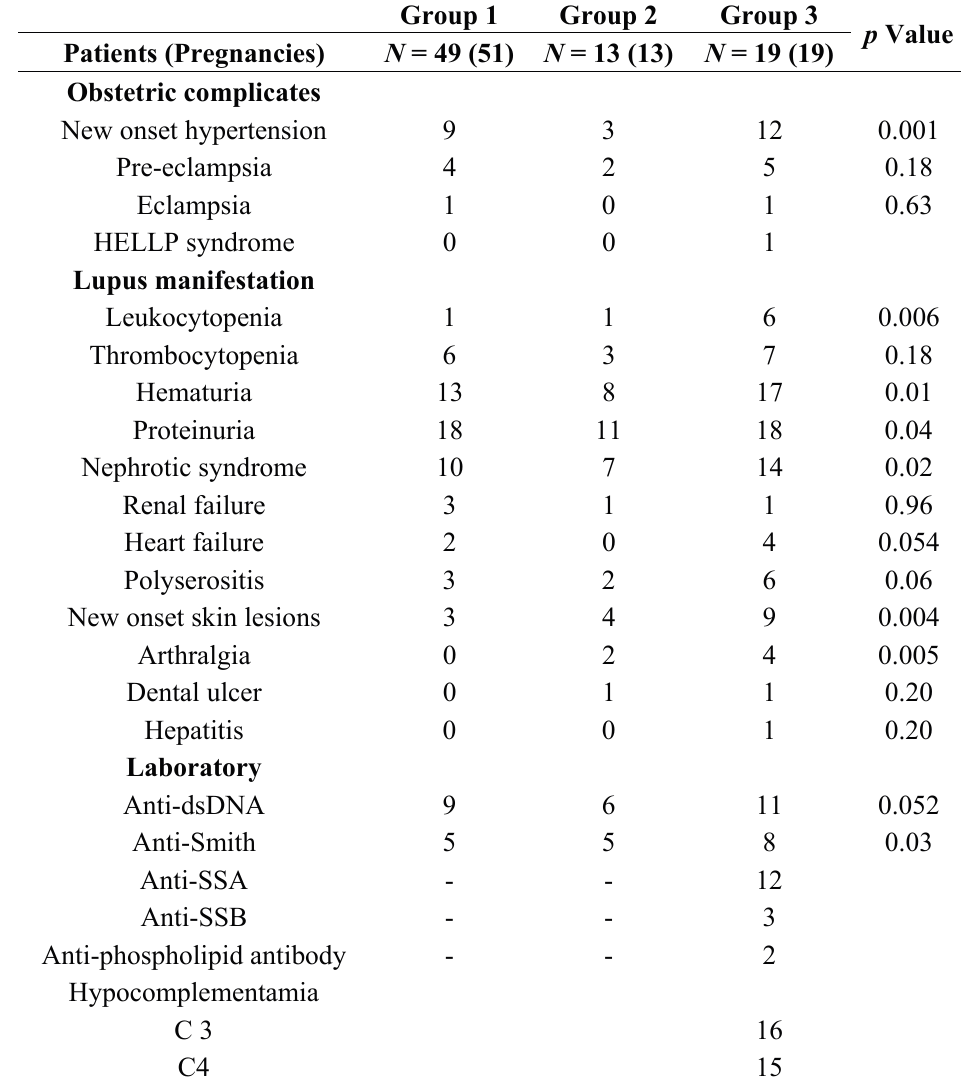
Table 3. Clinical manifestations during